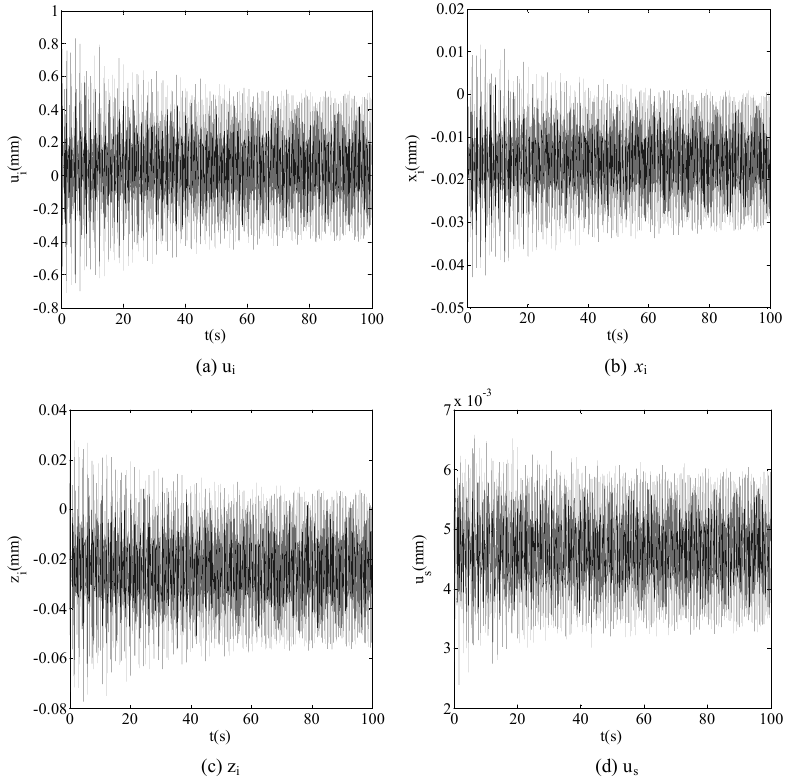
Fig. 5. The forced responses of the drive system to the dynamic eccentric center ( ω = 540 rad/s). numbers of the single modes equal ones of the planets. As the eccentric center of the worm occurs, the natural frequency and the planet’s de fl ection are not in fl